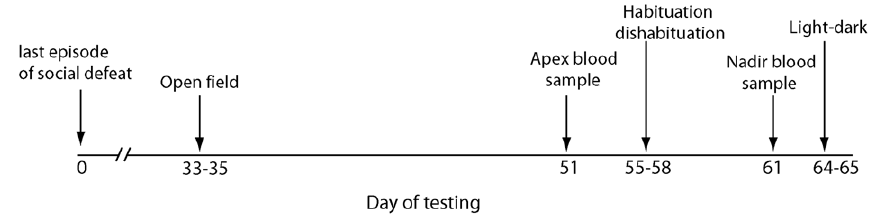
Figure 3. Timeline of procedures in Experiment 2.